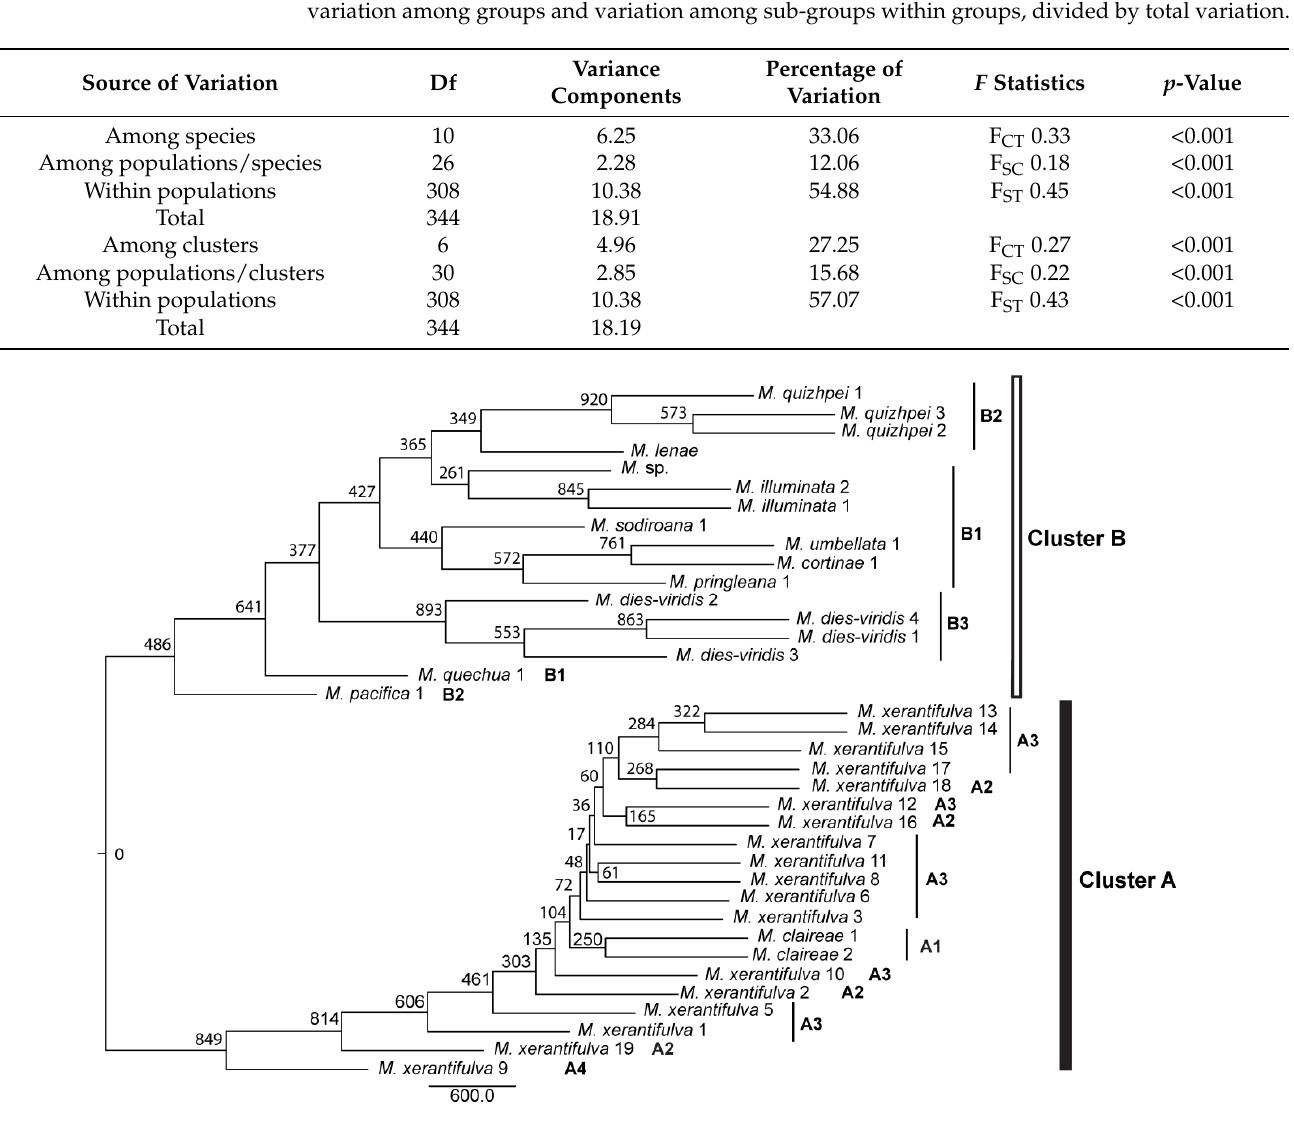
Figure 3. Neighbor- joining (NJ) dendrogram computed from Nei’s genetic distances from AFLP loci. Values at the nodes correspond to bootstrap support (N/1000) obtained by recalculating genetic distances from bootstrapped loci. The codes A, A1 to A4, B and B1 to B3 refer to genetic clusters identified by the Bayesian clustering method performed with STRUCTURE.